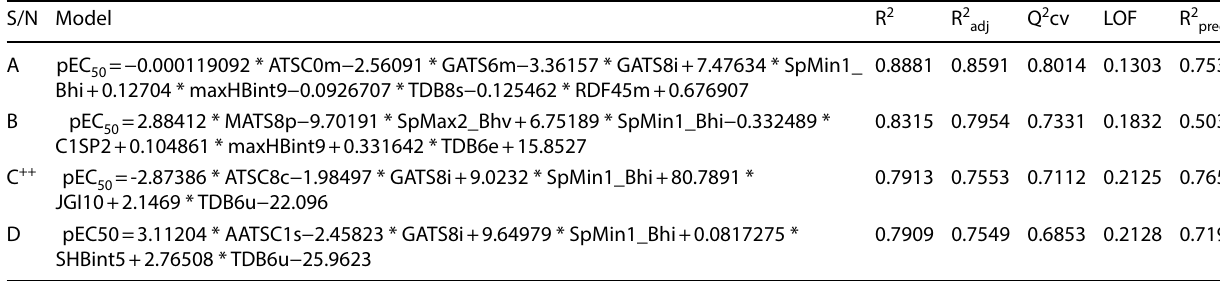
Table 2 Regression equations with their statistical validation parameters